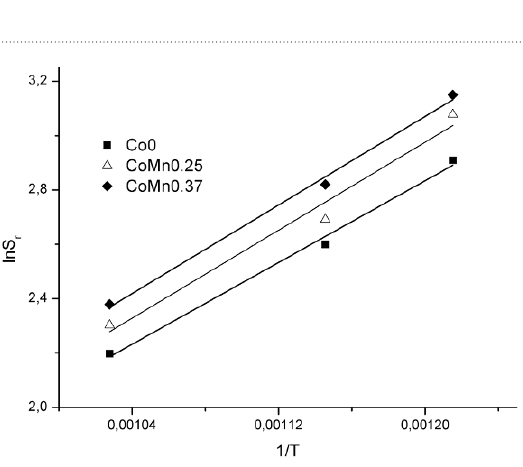
Figure 2. Dependence of the residual specific surface area, S , of cobalt catalysts on temperature of sintering r in an atmosphere of